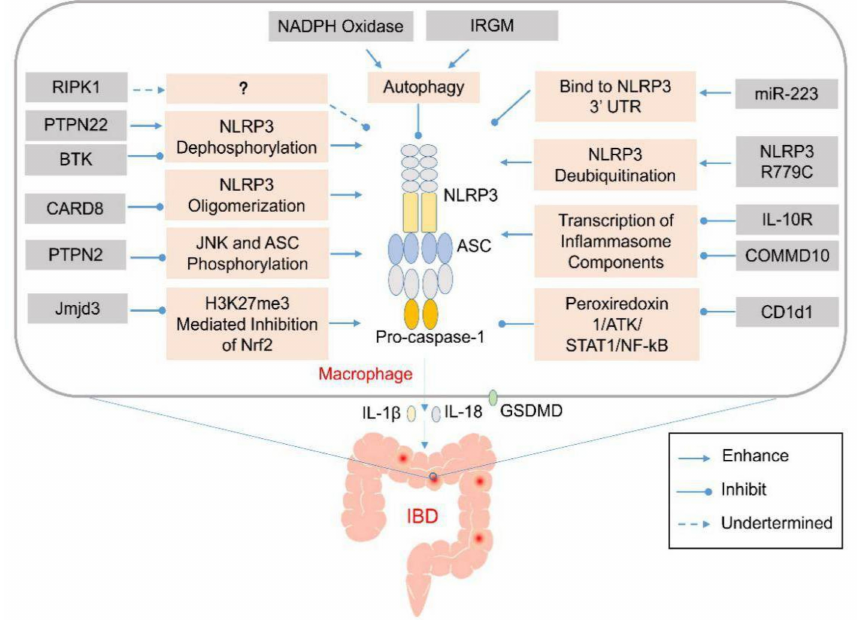
Figure 1. Genetic abnormalities affect development of inflammatory bowel disease (IBD) by elevating the activation of inflammasomes via various cellular processes. Various genetic factors might prevent the activation of the NLRP3 inflammasome via various mechanisms that affect NLRP3 oligomerization or modulate autophagy. Their absence might induce aberrant activation of the NLRP3 inflammasome and excess production of IL-1 β and IL-18 in the infiltrating macrophages or dendritic cells in the lamina propria of the colon. The released pro-inflammatory cytokines and pyroptosis-mediated release of cellular contents might recruit other inflammatory mediators to promote the expansion of the colonic